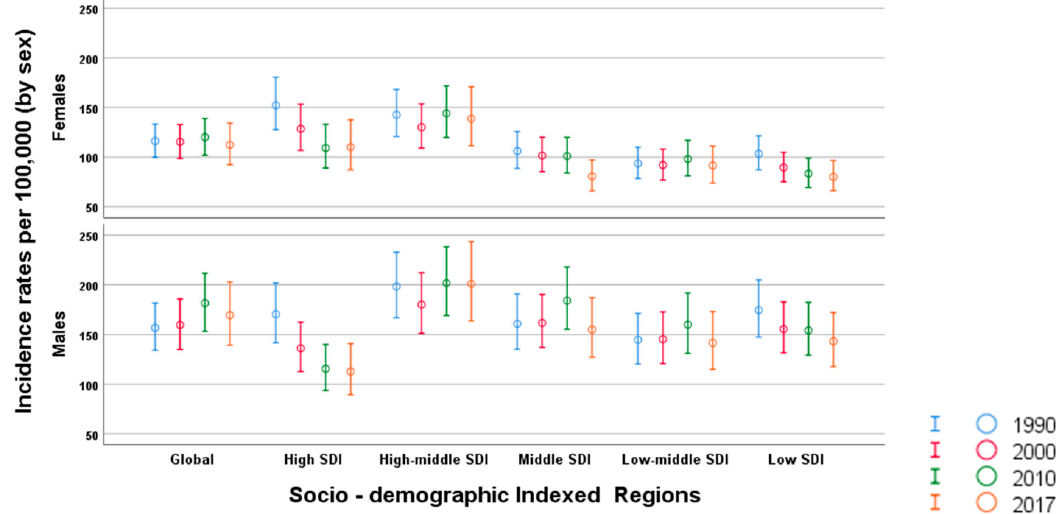
Figure 1. Incidence trends due to pedestrian road traffic injuries by sociodemographic indexed regions 1990 – 2017.